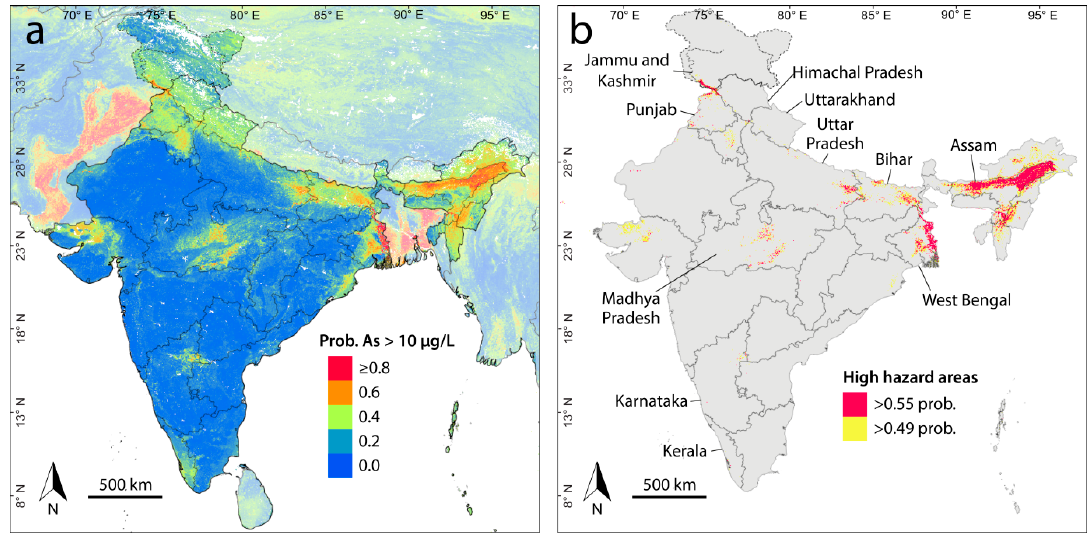
Figure 2. Arsenic hazard maps. ( a ) Probability of arsenic concentration in groundwater exceeding 10 µg/L. ( b ) High hazard areas in India based on probability cutoffs of 0.49 and 0.55.